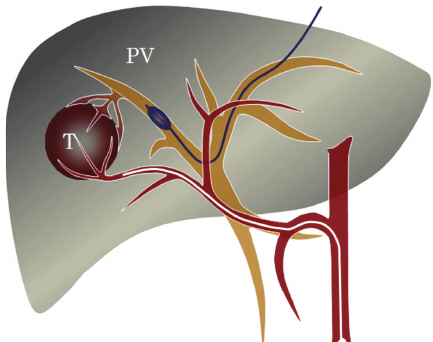
Figure 3: Schema of TACE under portal vein occlusion for HCC with significant arterioportal shunts. T: tumor; PV: portal